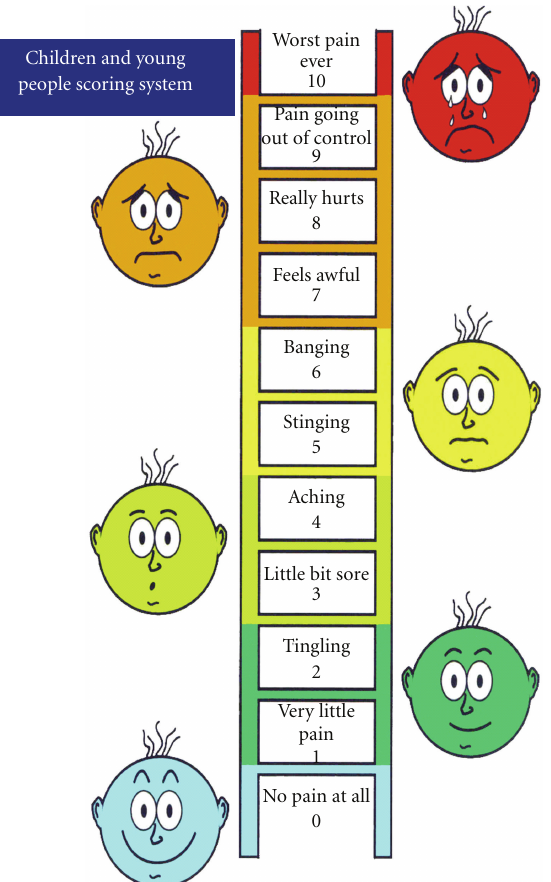
Figure 3: Paediatric Pain Assessment: FACES ladder. Useful in children ≥ 4 years of